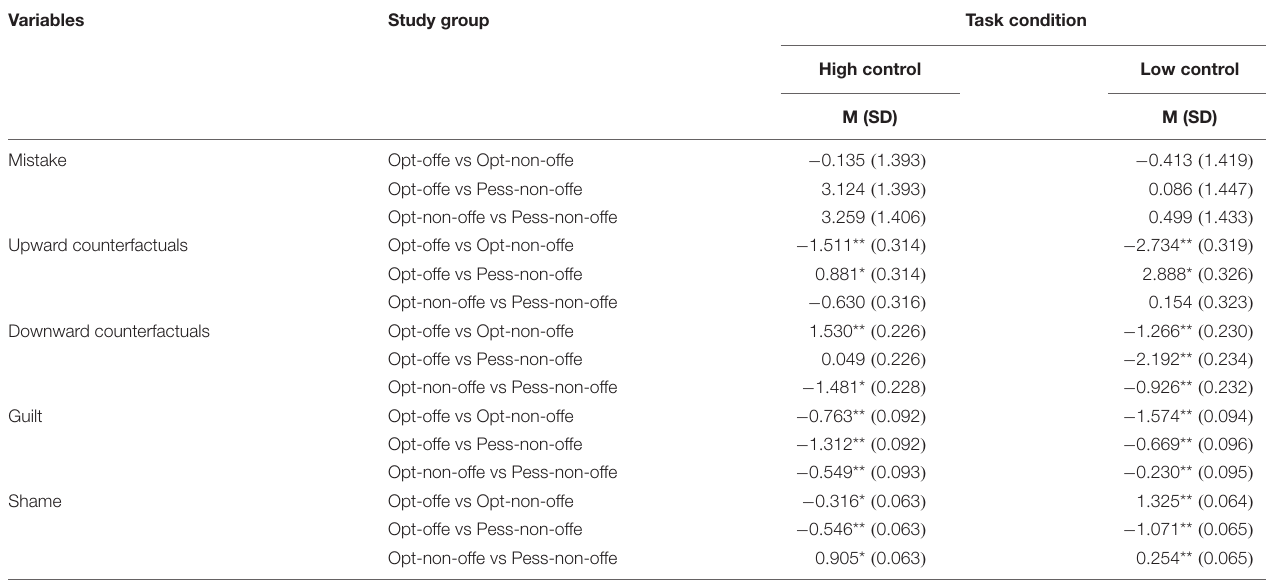
TABLE 3 | Difference in means and standard error between the optimistic offender and the optimistic non-offender and pessimistic non-offender groups under task condition for the following variables: mistake, upward counterfactuals, downward counterfactuals, guilt, and shame.